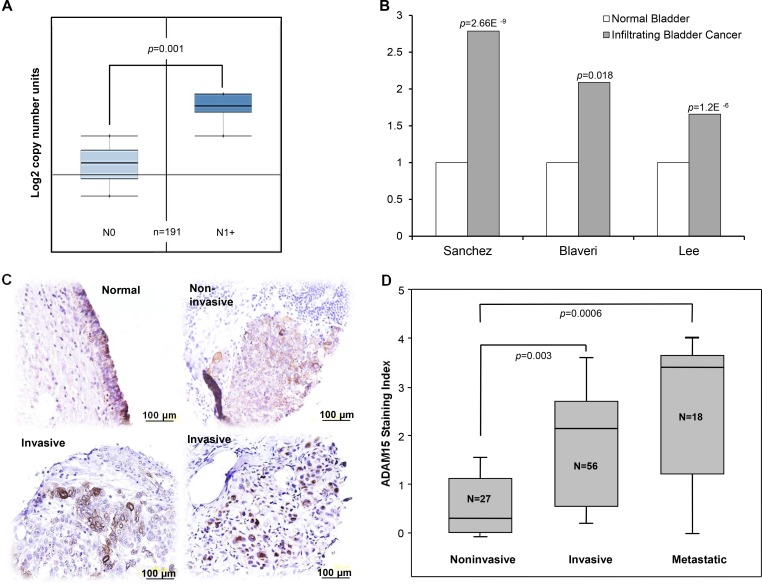
The metastatic progression of human bladder cancer is associated with elevated DNA copy number and increased ADAM15 expression.Analysis utilizing the OncomineTM (Compendia Bioscience) gene browser. A) Boxplots summarize mean copy number and standard deviation (SD) of a bladder cancer gene expression data set. ADAM15 copy number was elevated in invasive bladder cancer (N1+) compared to noninvasive disease (N0). B) ADAM15 mRNA is overexpressed in invasive bladder cancer compared to noninvasive bladder cancer. Bars represent ADAM15 mRNA levels in three different published mRNA expression studies. C) Microphotographs of ADAM15 immuno-staining of a bladder cancer progression tissue arrays. Three pathological stages are represented (normal tissue, noninvasive, and invasive bladder cancer). D) Boxplots represent the ADAM15 staining index in this TMA as mean ± SD. Invasive and metastatic bladder cancer specimens exhibited significantly increase staining index compared to noninvasive disease.